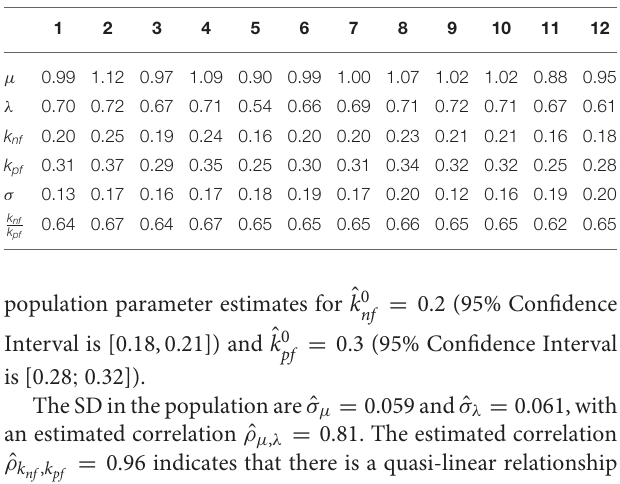
TABLE 1 | The individual parameter estimates with constrained nonlinear least square (CNLS) for tubes i = 1, ...